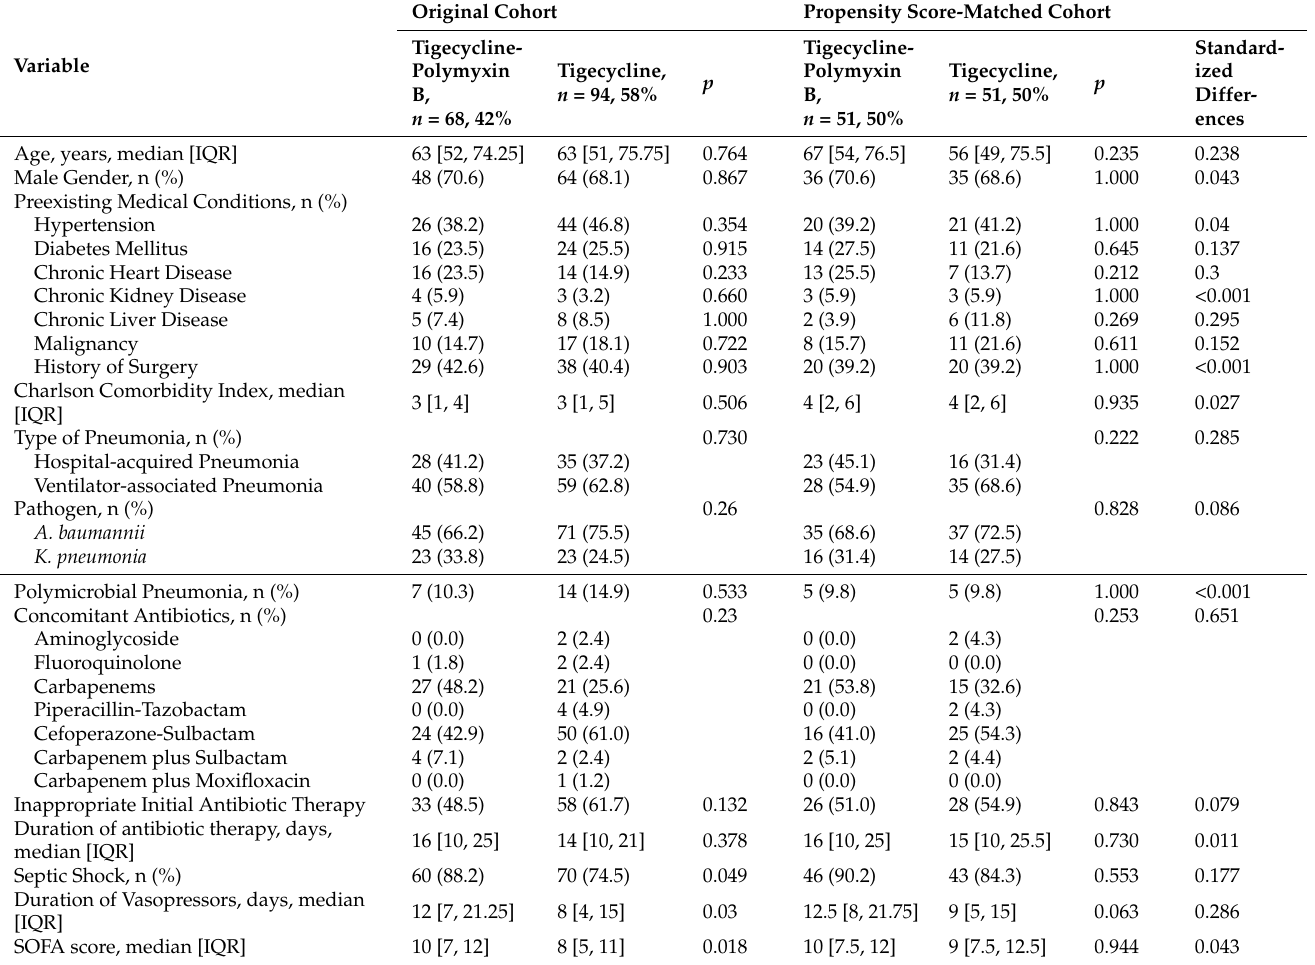
Table 1. Characteristics of patients with nosocomial pneumonia caused by carbapenem-resistant A. baumannii or K. pneumoniae .